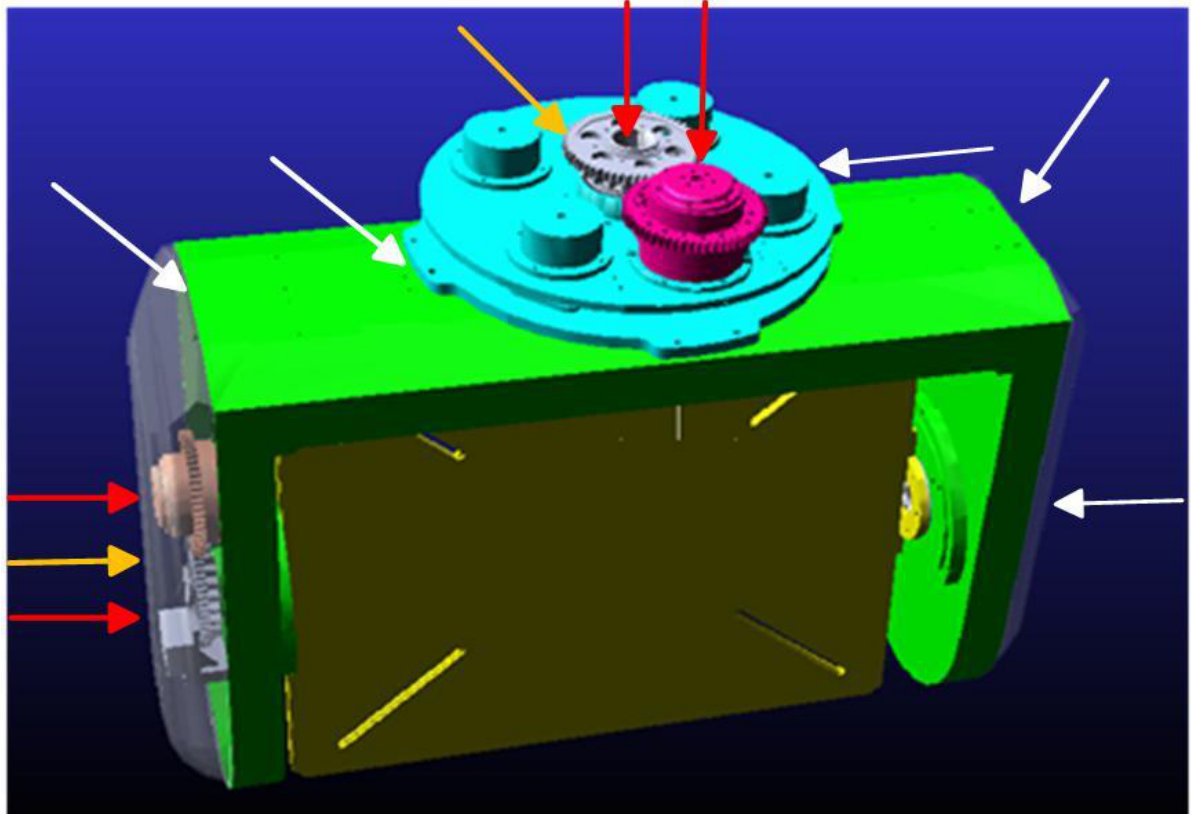
Figure 9. Constraints addition of ISP under